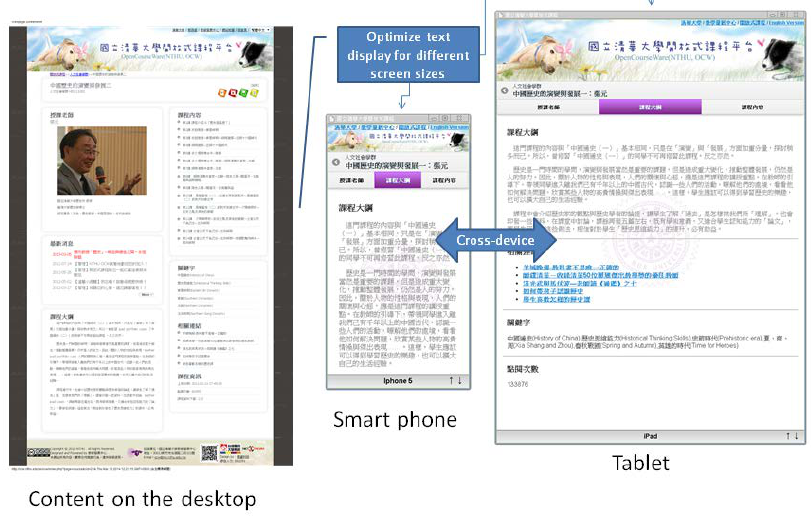
Figure 3 . Readability of cloud-computing responsive web system.